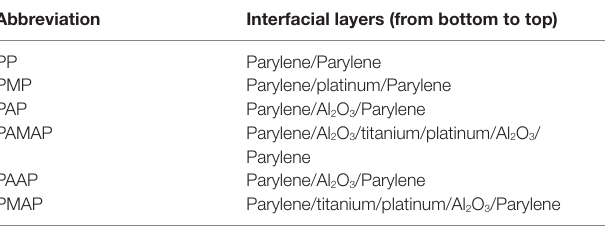
TaBle 2 | Different material combinations investigated for flexible Parylene devices.